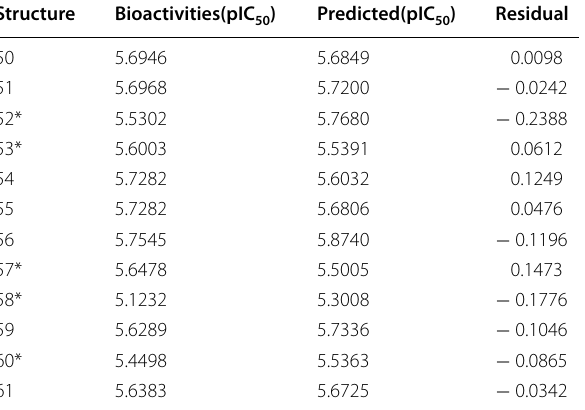
), predicted (pIC 50